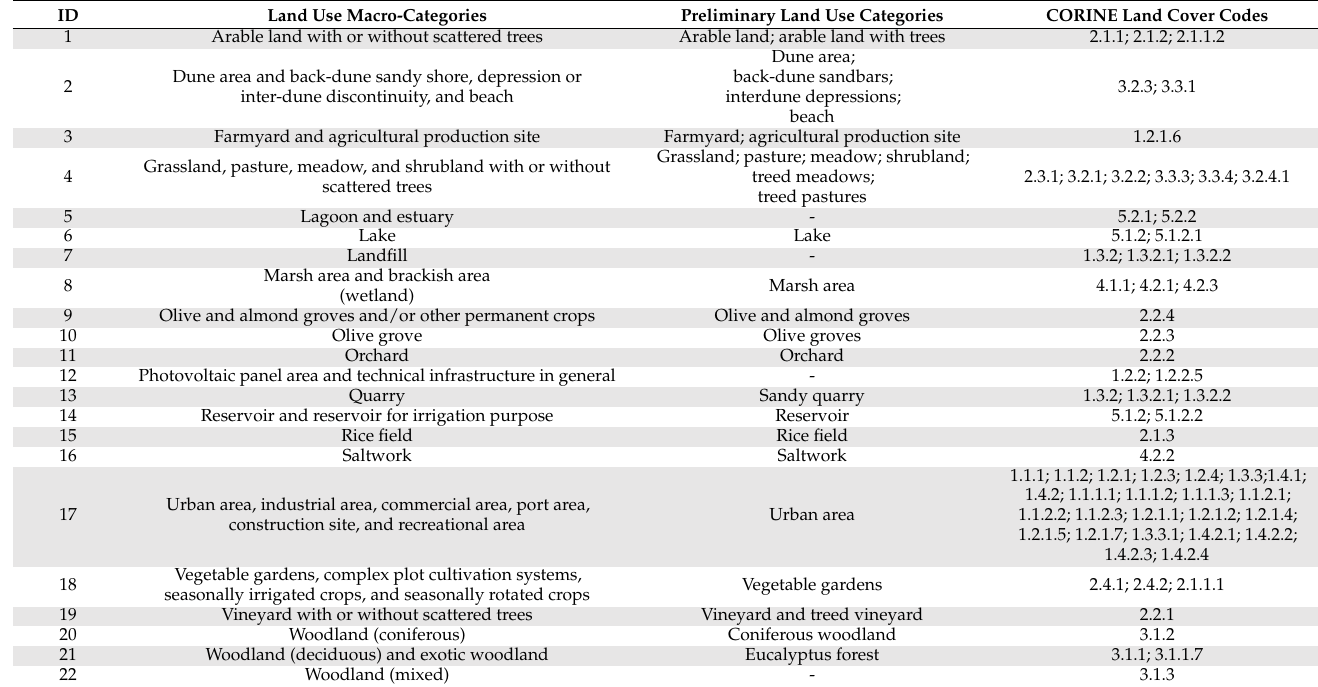
Table 3. Land use categories proposed for the land use classification. In column 1, the ID number is indicated; in column 2, the macro-categories proposed for the long-term comparison are indicated; in column 3, the categories defined by analysing the historical cartographic maps are listed; in column 4, the CORINE Land Cover codes indicated in national and regional repositories are